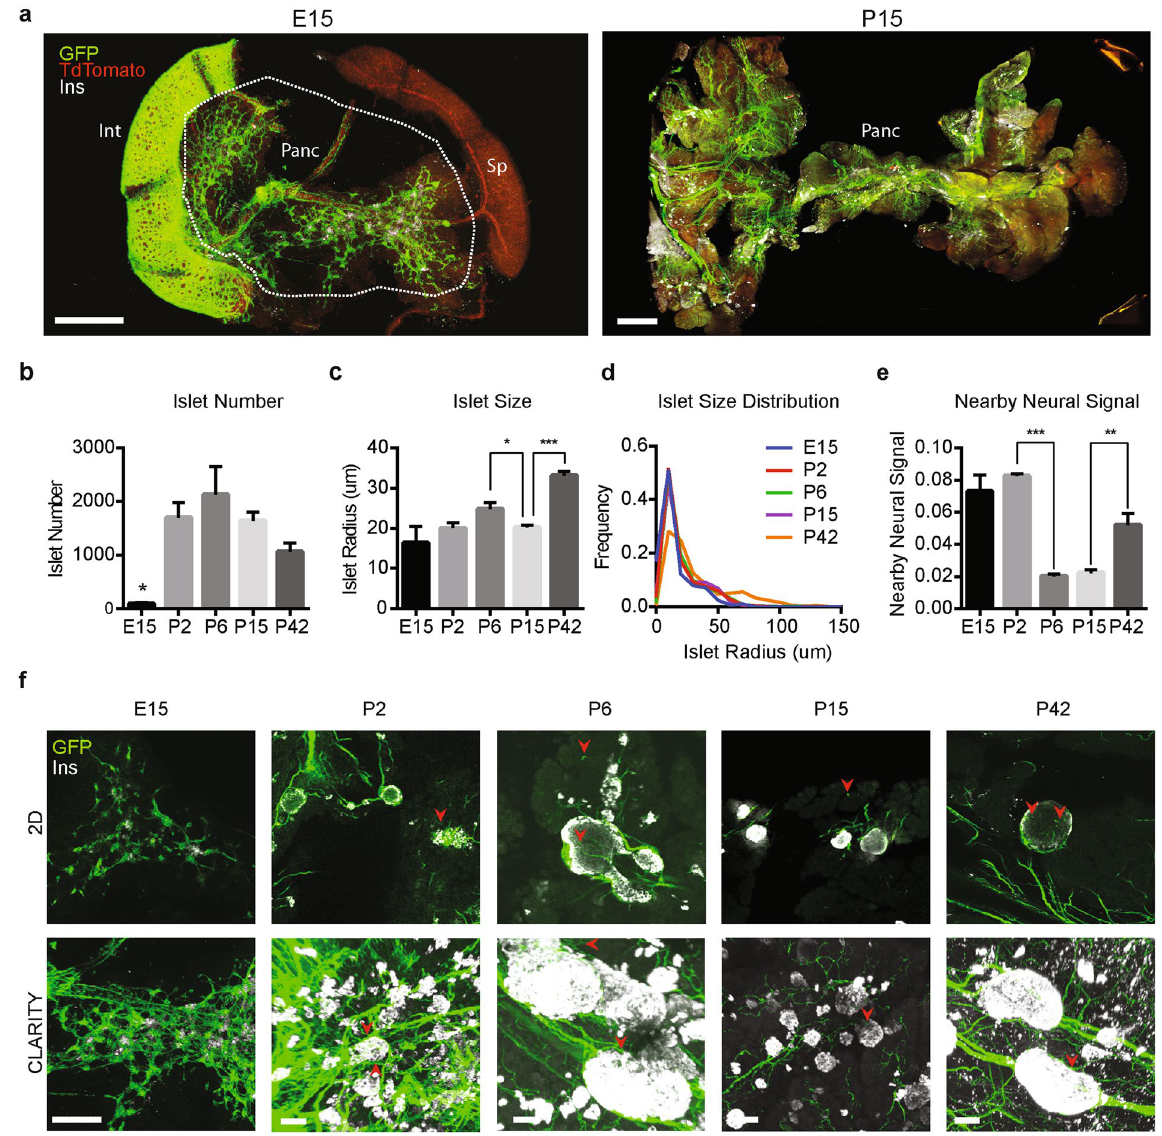
Figure 2. Neuroendocrine pancreas in mouse development. ( a ) Pancreata from Wnt1-Cre x Rosa26-mT/mG reporter lines at E15 (left) and P15 (right) were harvested, processed using CLARITY, and stained for insulin. 3D histology enables organ-wide visualization of developing islets (white) and associated neural features (green) throughout the pancreas; imaging datasets were then automatically processed with the computational pipeline (see Fig. S2). Int: intestine, Panc: pancreas, Sp: spleen. All samples were embedded with A1B1P4 hydrogel and cleared for 1–2 weeks at 37 °C. Scale bars = 1000 μ m. ( b ) Automated quantification reveals changes in islet size and number at various stages of pancreatic development. Note massive expansion of islet number shortly following birth (p < 0.05, unpaired t-test) through P6, followed by reduction. ( c ) Islet size is also non- monotonic with aggregate size reduction (P6–P15, p < 0.05, unpaired t-test) and growth (P15–42, p < 0.0005, unpaired, t-test). ( d ) CLARITY enables refined whole-population measurements, as illustrated by a population shift towards larger islets at P42 compared to other timepoints. ( e ) The presence of neural crest structures in the neighborhood surrounding and within pancreatic islets was quantified. The level of neural crest-islet interaction is dynamic with a significant decrease between P2 and P6 (p < 0.0005, unpaired t-test) and a significant increase between P15 and P42 (p < 0.005, unpaired t-test). ( b – e ) n = 3 pancreata from litter mates per developmental stage, error is s.e.m. ( f ) Optical 2D sections (5 μ m thick; top row) and corresponding 3D CLARITY images (1000 μ m thick, bottom row) across development. While 2D sections suffice to observe gross changes in islet size, neural structures (arrowheads) are sparse and difficult to quantify in 2D. CLARITY reveals high- resolution structure not captured by 2D images, enabling visualization of neural remodeling dynamics. Scale bars = 100 μ